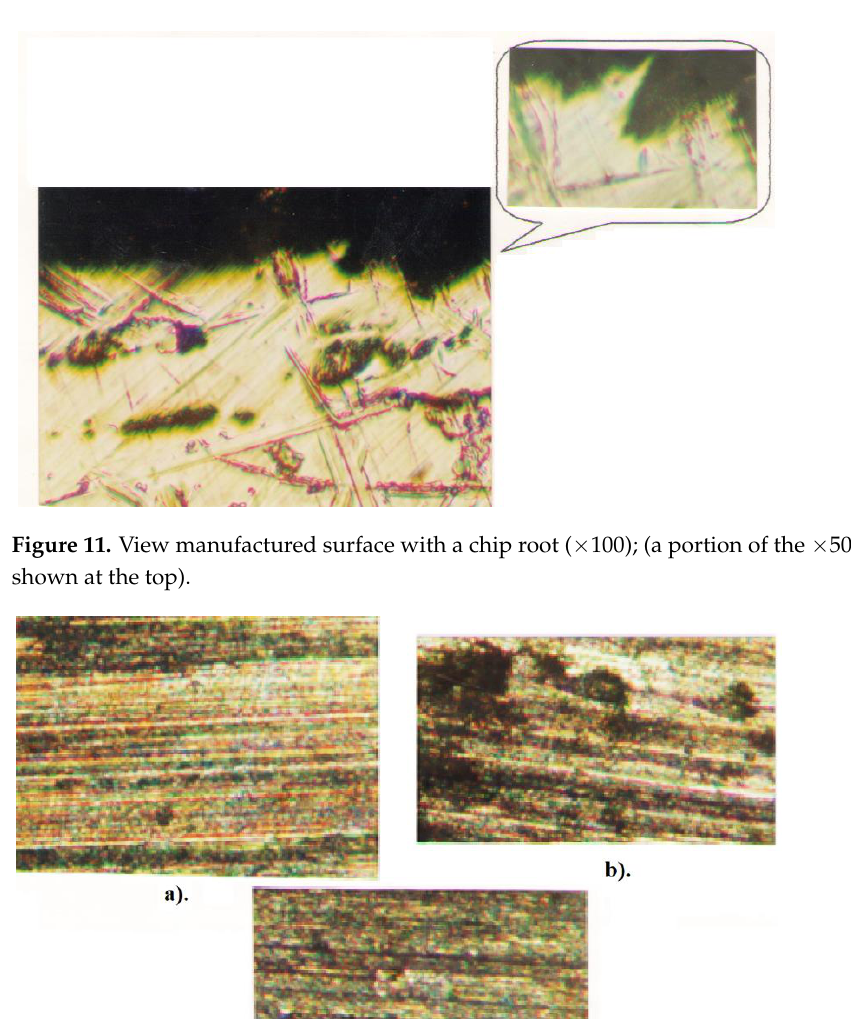
Figure 10. The topography of the manufactured surface, measured on Talysurf 120L.